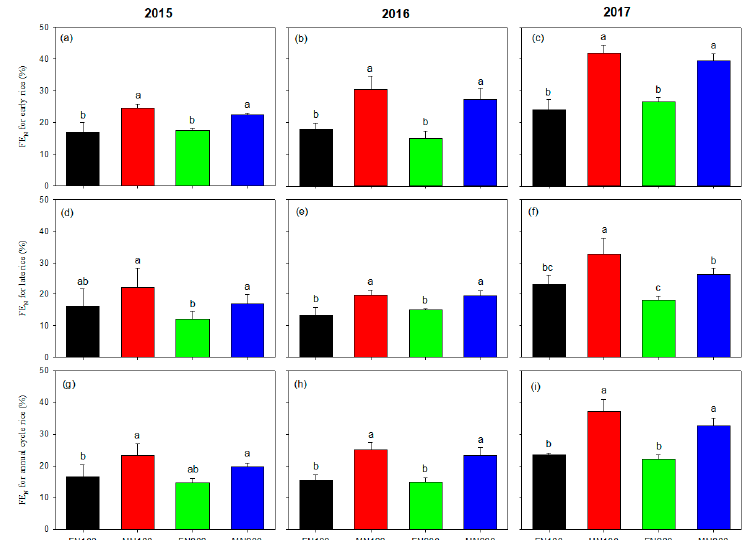
Figure 4. Fertilizer N recovery e ffi ciency for early ( a – c ), late ( d – f ), and annual cycle ( g – i ) rice from 2015 to 2017. FN 0 represents winter fallow without N application in rice seasons as a check, MN 100 represents vetch cover cropping with 100 kg N ha − 1 each rice season, FN 100 represents winter fallow with 100 kg N ha − 1 each rice season, MN 200 represents vetch cover cropping with 200 kg N ha − 1 each rice season, and FN 200 represents winter fallow with 200 kg N ha − 1 each rice season. The data shown in the panels are averages of the three replications for individual treatments. Vertical bars represent the standard errors. Di ff erent lowercase letters represent the significant di ff erences at p <